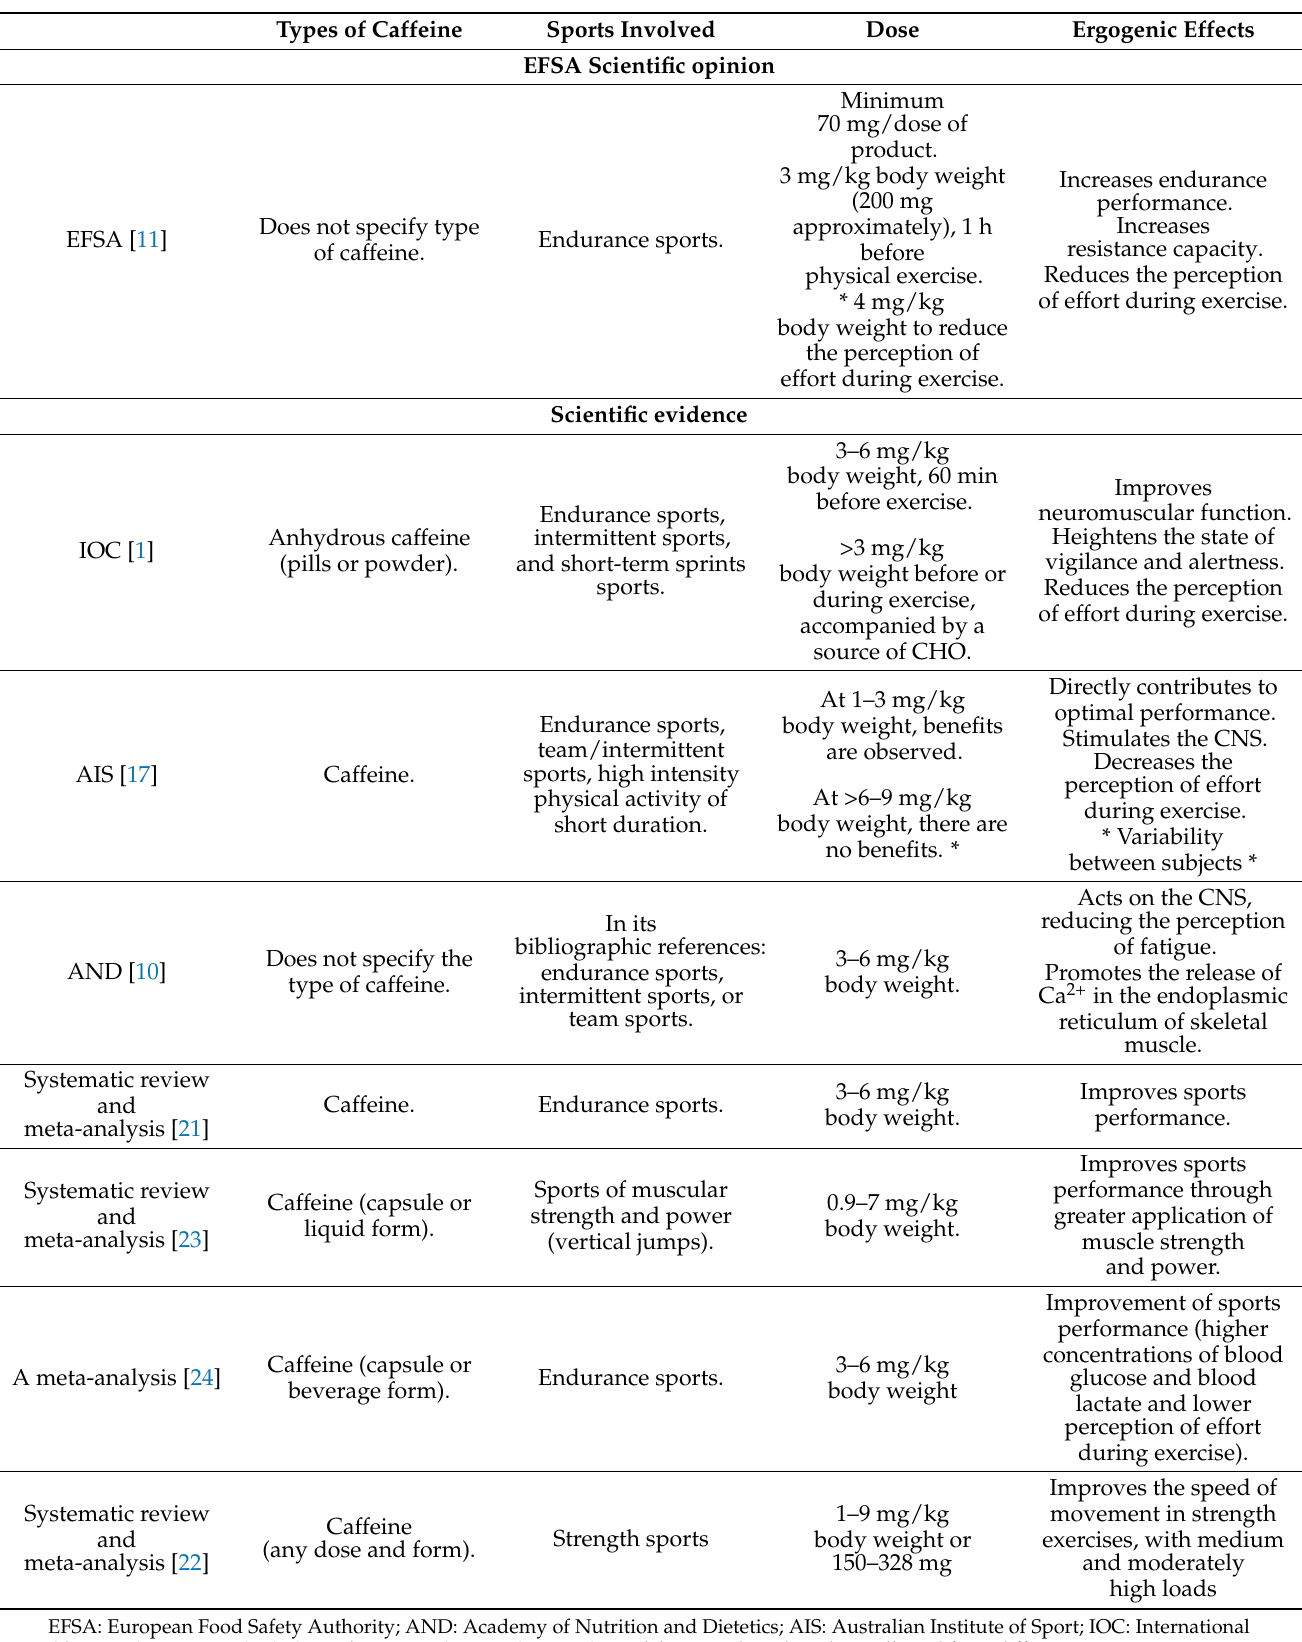
Table 2. Effects and applications of caffeine established by the EFSA scientific opinion and the scientific evidence and criteria provided by the literature and International